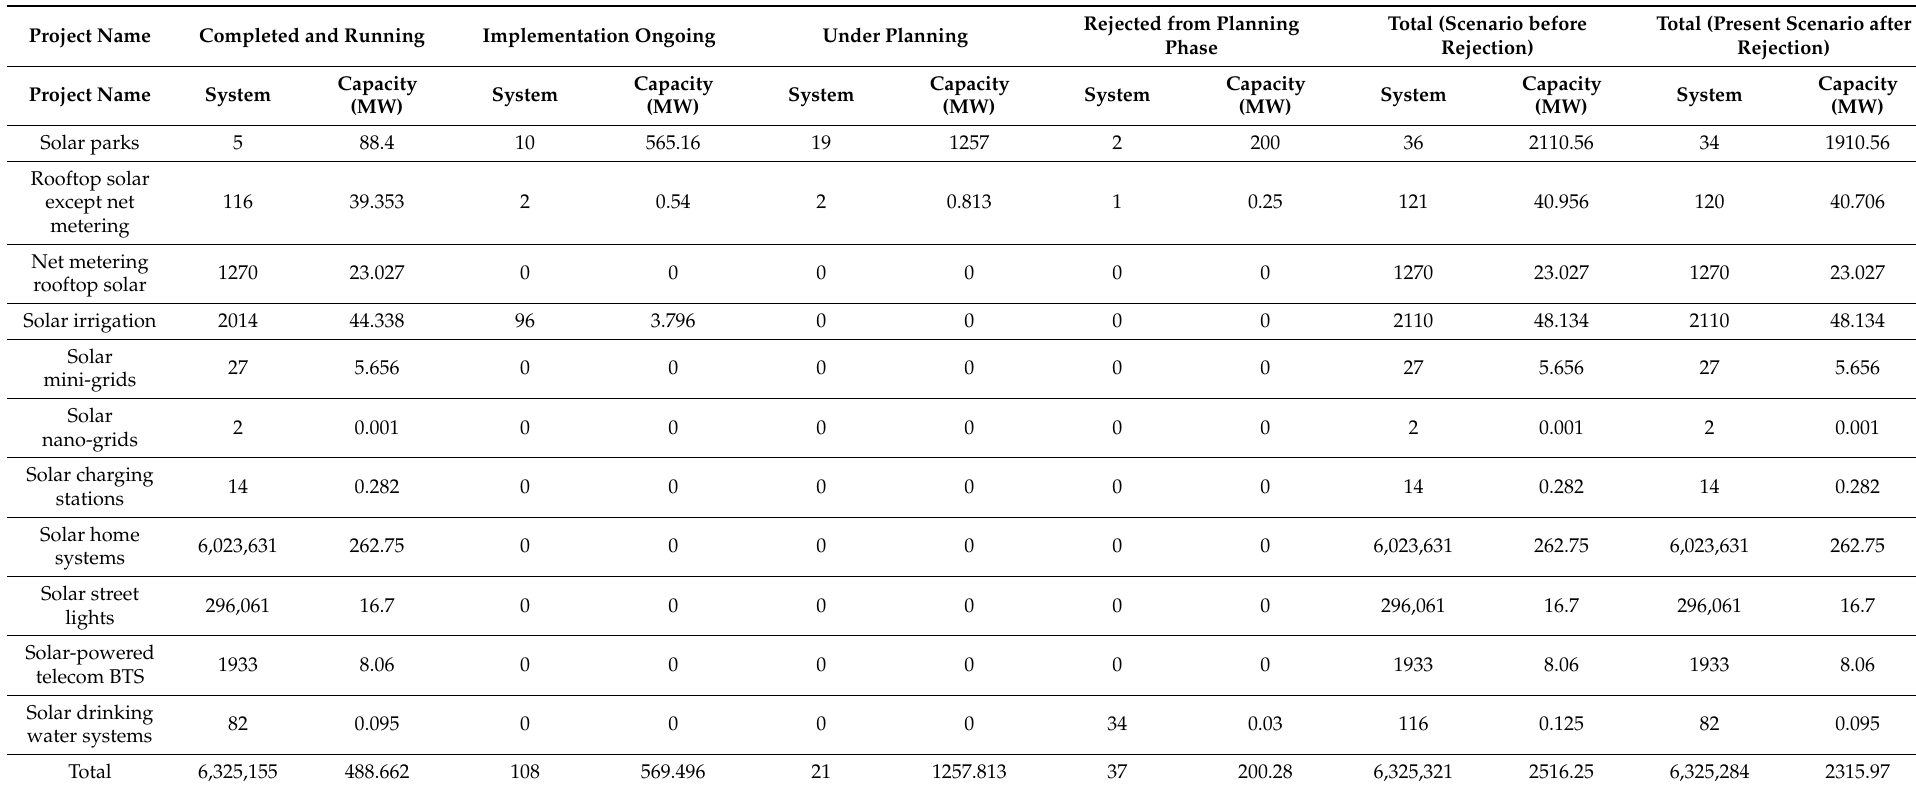
Table 5. Solar energy projects in Bangladesh (authors’ creation based on SREDA data